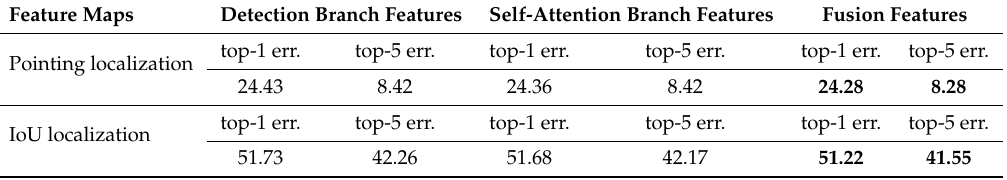
Table 7. Comparison of feature maps from different branches on the CUB-200-2011